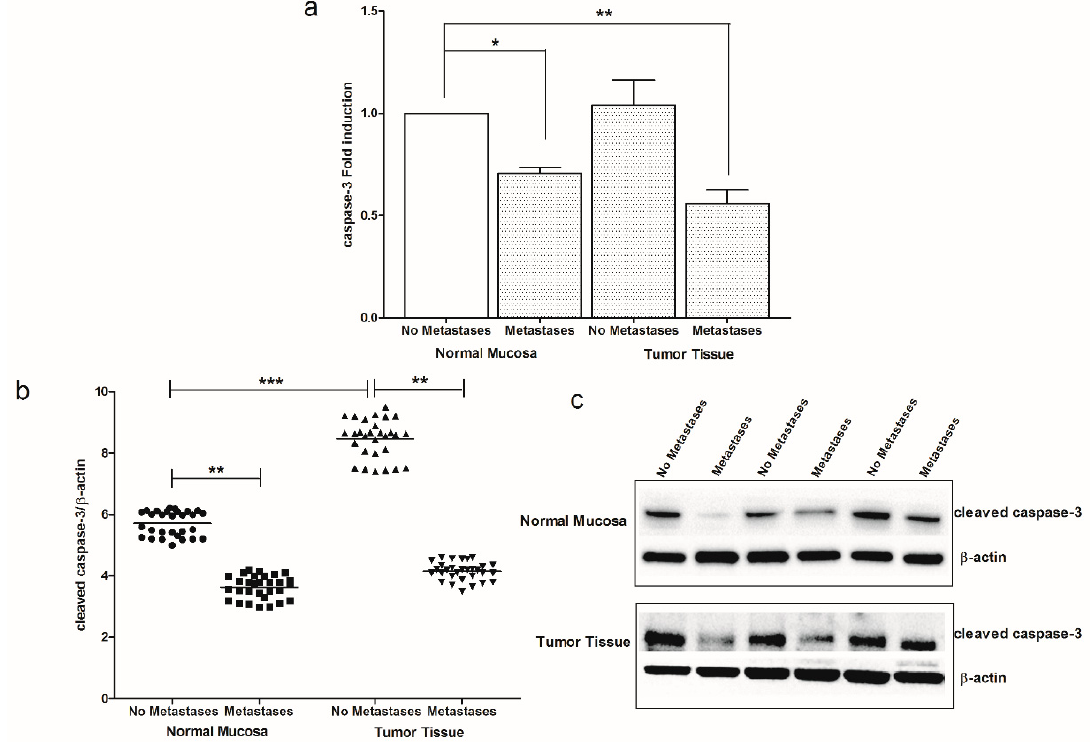
Figure 7. ( a ) Caspase-3 gene expression levels in intestinal tissue of no metastases ( n = 29 patients) and with metastases patients ( n = 30 patients) detected in both normal mucosa and tumor tissue. Data, expressed as mean value ± SD, are presented as fold induction compared to normal mucosa of patients without metastases. ( b ) Dot plots graph of cleaved caspase-3 protein values detected in our patients groups. * p < 0.05, ** p < 0.02, *** p < 0.001 indicate statistically significant differences (one-way analysis of variance with Dunnett’s and Tukey’s multiple comparison test, where appropriate). ( c ) Representative Western blot bands of cleaved caspase-3 and β -actin proteins.